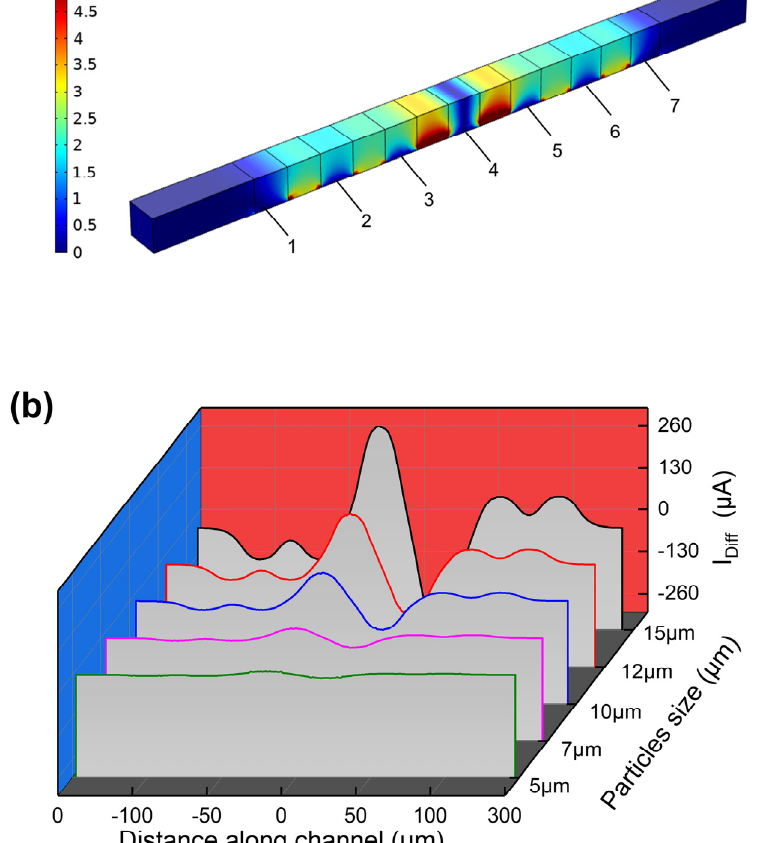
Figure 5. ( a ) Current density distribution. In the figure, number 4 represents the central electrode, numbers 3 and 5 represent the GND electrodes, numbers 2 and 6 represent the floating electrodes, and 1 and 7 represent the electrodes with opposite phase angles to the central electrode. ( b ) Differential current signals for different particle sizes: green represents 5 µ m particles, pink represents 7 µ m particles, blue represents 10 μ m particles, red represents 12 μ m particles, and black represents 15 μ m particles.